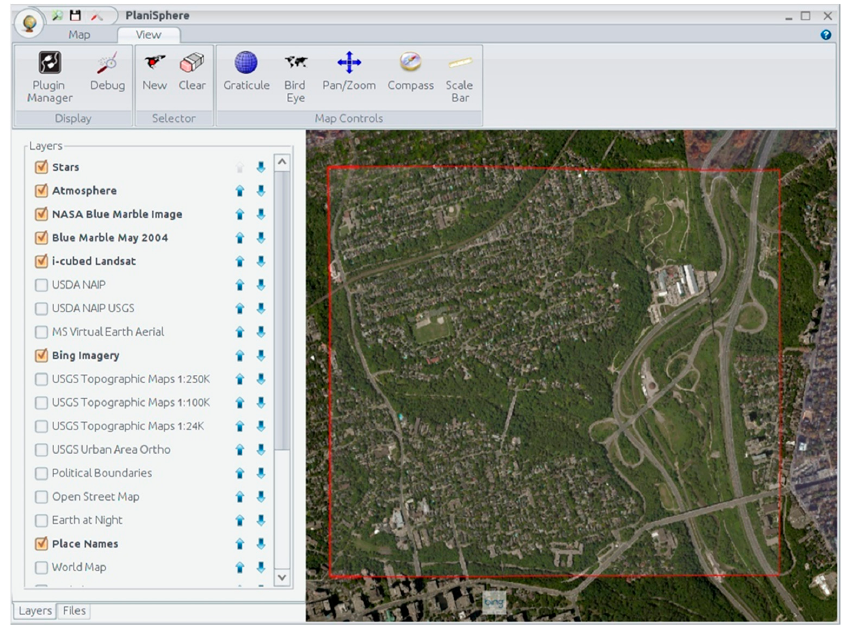
Figure 2. Main graphical user interface (GUI) window.